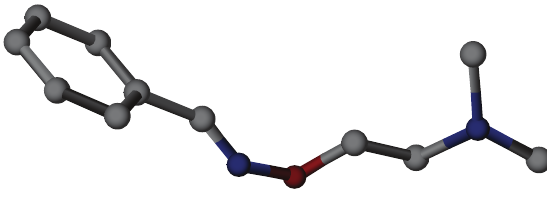
Figure 1: Common skeleton of target